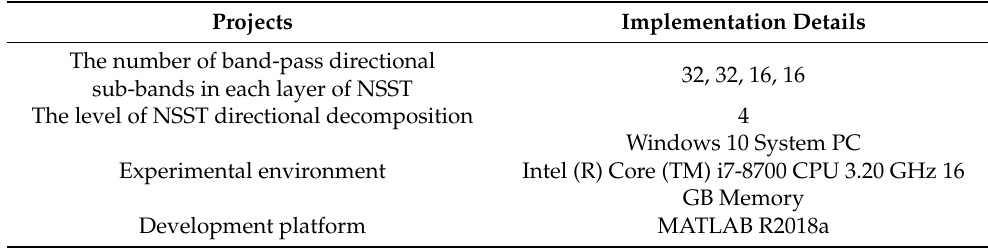
Table 1. Implementation details.